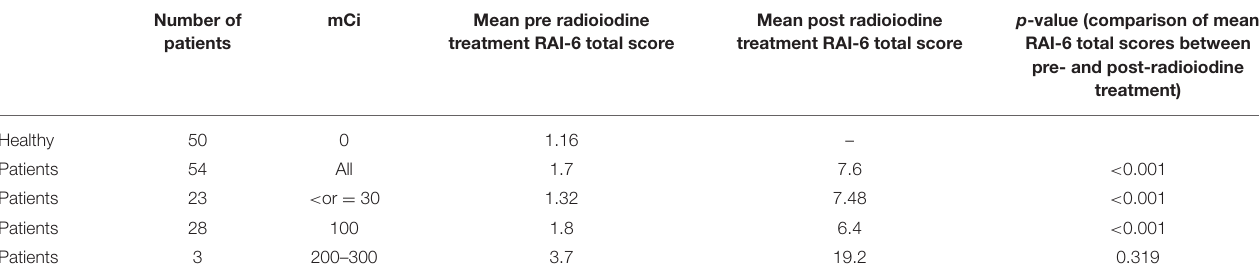
TABLE 3 | Healthy volunteers RAI-6 scores and pre- and post-radioiodine therapy patient’s mean RAI-6 scores according to the radioiodine dose received. Number of mCi Mean pre radioiodine patients treatment RAI-6 total score